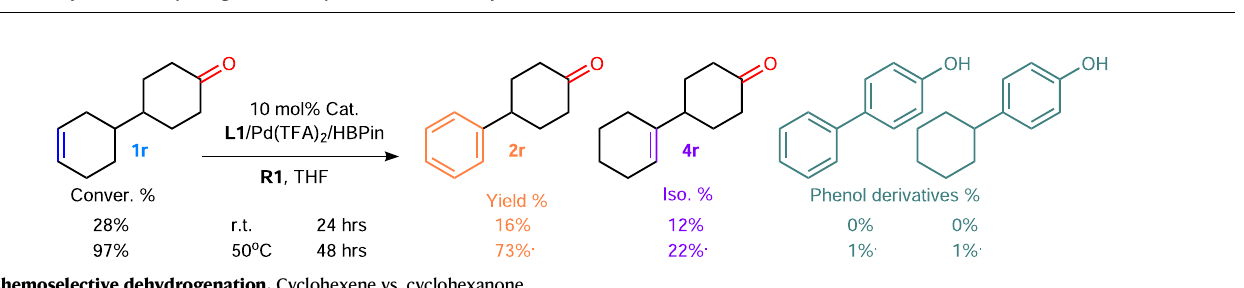
Fig. 8 | Proposed catalytic cycle at this stage. I Chain-walking isomerization. II Chemoselective and regioselective hydropalladation of regulator R vs. 1 , 1 ′ & 1 ″ . III H-transfer (major). IV Catalyst regeneration by isomerization and β -H